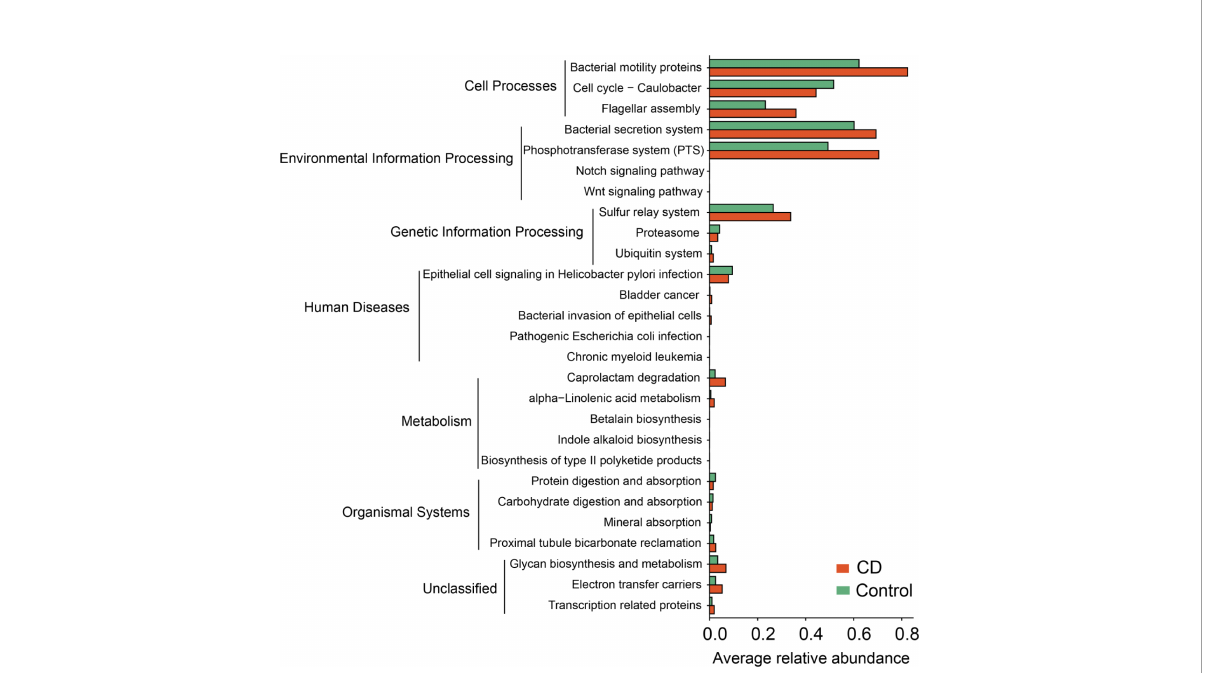
FIGURE 8 Functional alterations in the microbiota of CD. Based on the estimations with PICRUSt, pathway enrichment analysis was conducted to compare between the CD and the control groups. 27 differential KEGG pathways ( P < 0.05) in 6 functional categories were identi fi ed. P values were from paired